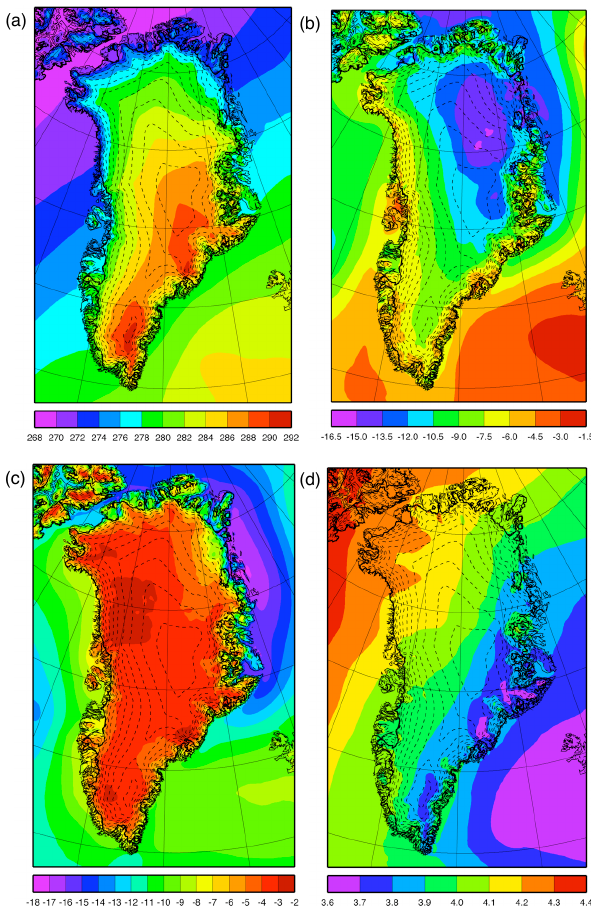
Fig. 6. Annual mean (a) background surface potential temperature [K], (b) surface potential temperature perturbation [K], (c) verti- cally integrated potential temperature perturbation [10 3 Km], and (d) lapse rate of the background potential temperature [Kkm − 1 ].